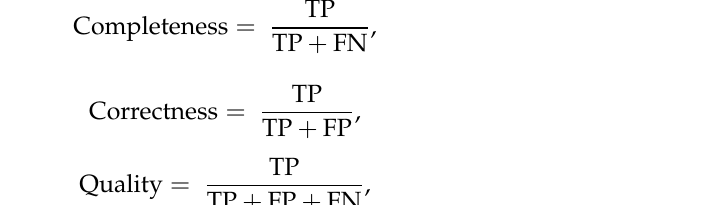
Figure 7. 3D View of the semantic labeling results for the three Vaihingen areas with five classes: ground (orange), building roof (blue), vegetation (green), façade (yellow), and other (red). ( a ) vs. Area 1, ( b ) vs. Area 2, and ( c ) vs. Area (3).